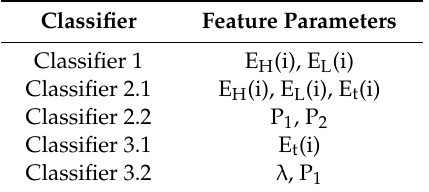
Figure 13. Overvoltage hierarchical recognition system based on particle swarm optimization- support vector machine (PSO-SVM). Table 2. Feature parameters of each